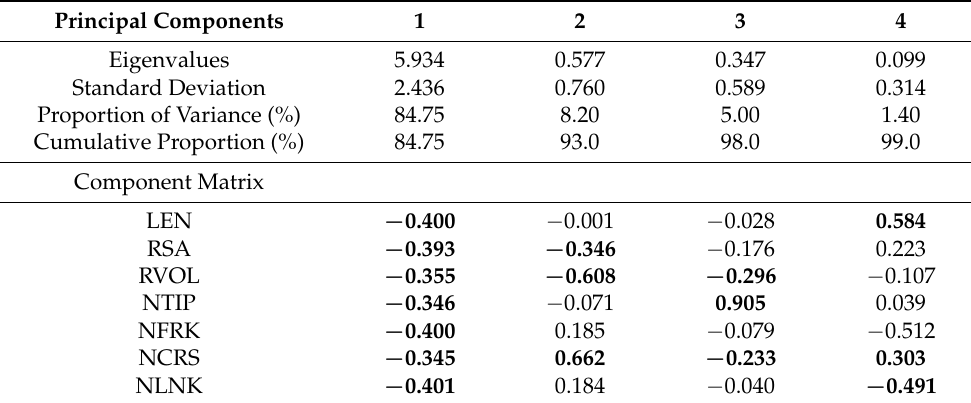
Table 3. Eigenvalues and percentage of total variation and component matrix for the principal component axes of seven root traits of seedlings for 267 Andean common bean genotypes grown under Al stress